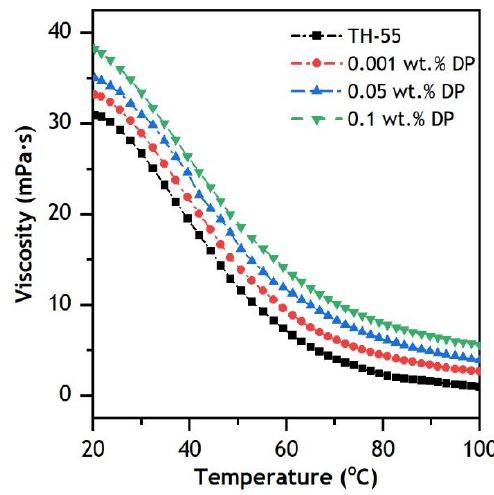
Figure 8. Variation of dynamic viscosity of TH-55/DP nanofluids at 20 – 100 °C.